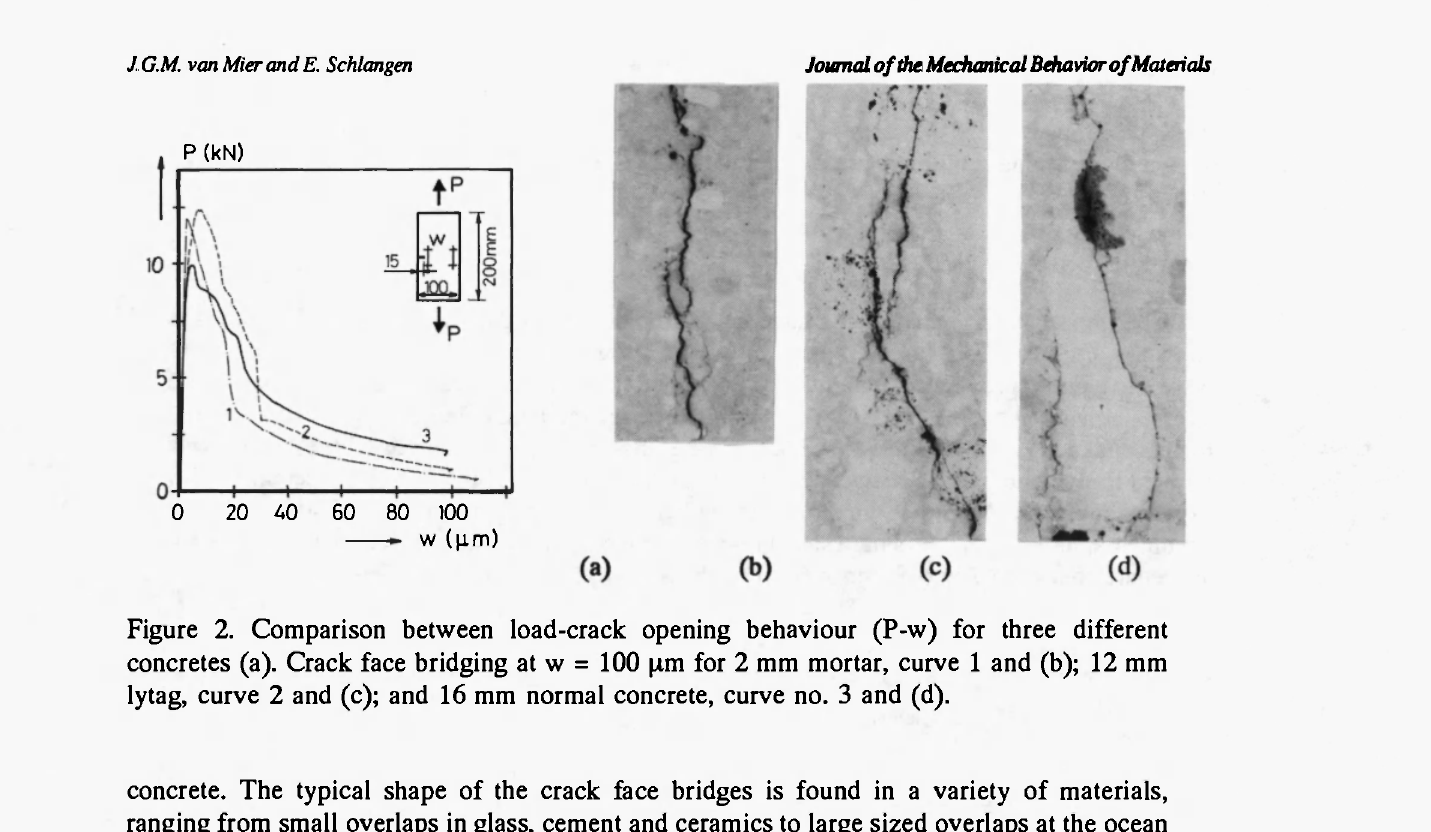
Figure 2. Comparison between load-crack opening behaviour (P-w) for three different concretes (a). Crack face bridging at w = 100 μπι for 2 mm mortar, curve 1 and (b); 12 mm lytag, curve 2 and (c); and 16 mm normal concrete, curve no. 3 and (d).